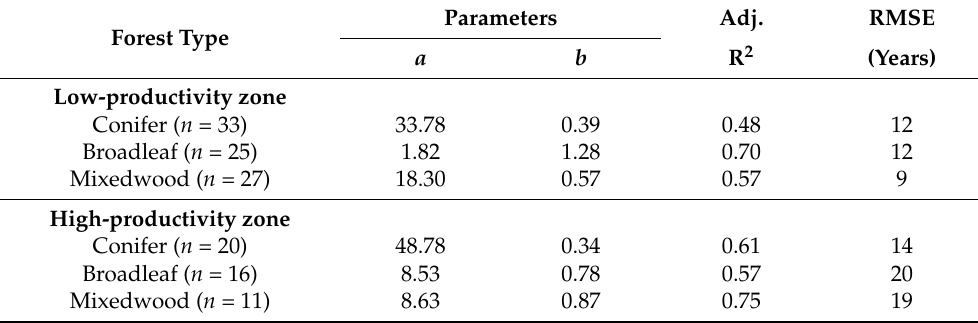
Table 6. Stand age models as a function of stand height ( x ), parameters. and goodness-of-fit (adjusted (Adj.) R 2 , root mean square error (RMSE)) metrics based on power function (y = a x b ) model form. The low-productivity zone consists of all ecoregions within the study area and Taiga Plains Ecozone other than the Liard Plain Mid-Boreal and Liard Upland Mid-Boreal ecoregions that comprise the high-productivity zone [29].